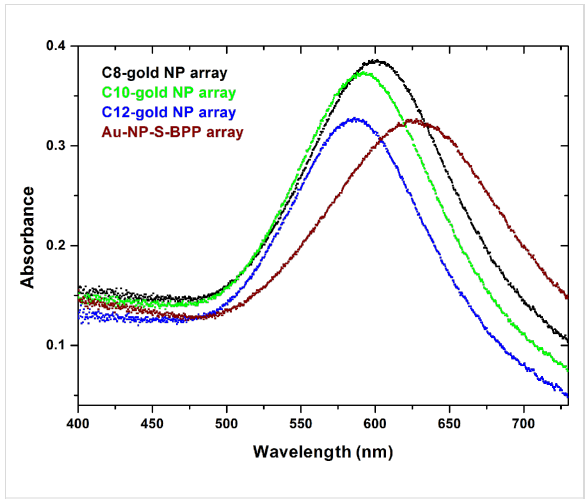
Figure 2: Surface plasmon resonance spectroscopy of several func- tionalized gold nanoparticle arrays studied in our work. Gold nanoparti- cles are covered by C8 (black), C10 (green), C12 (blue) and S-BBP (red), respectively.